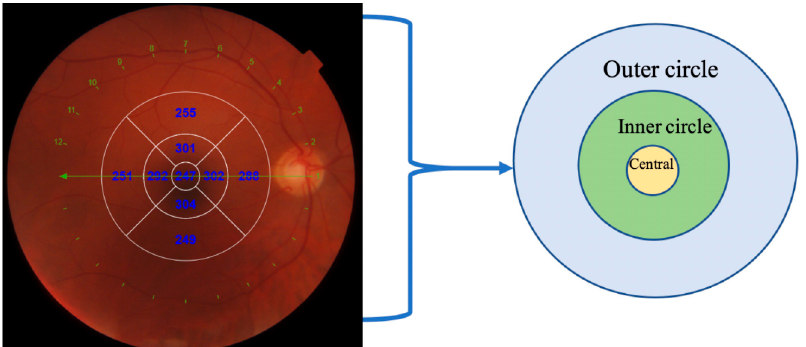
Figure 1. Calculation of retinal and choroidal thickness.